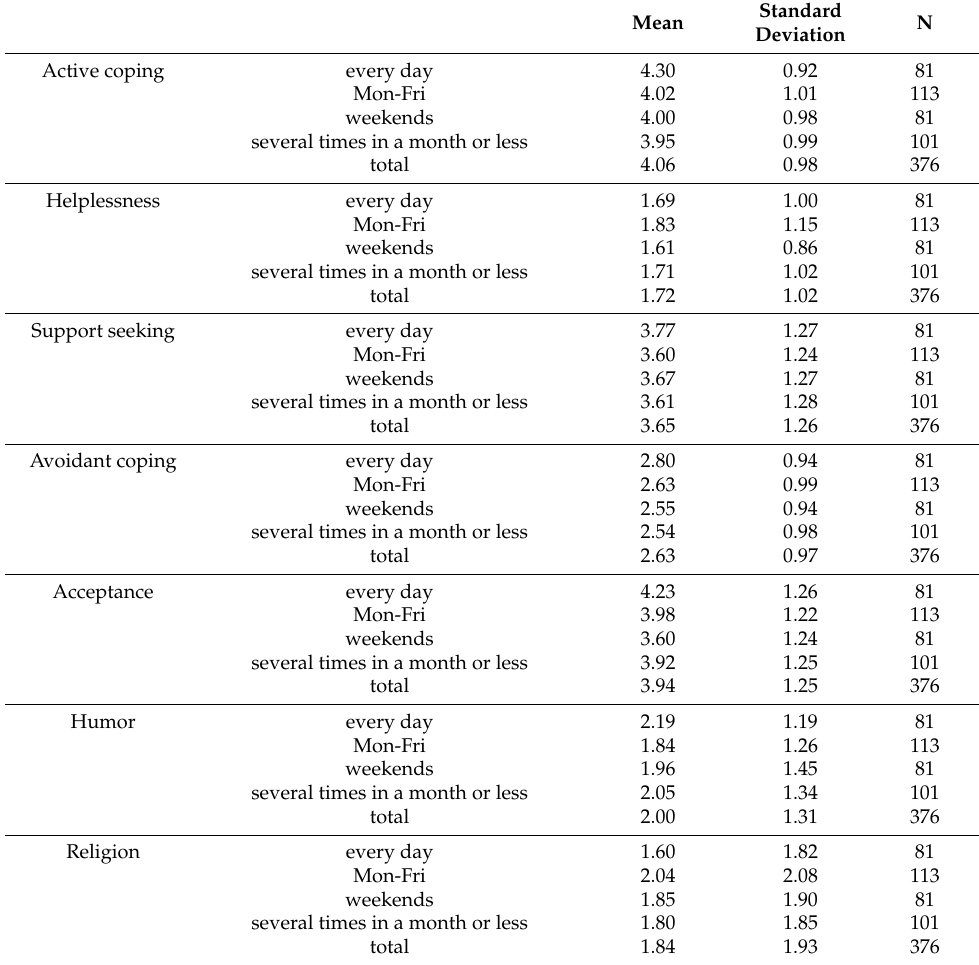
Table A2. Descriptive statistics for coping strategies in four groups of forest